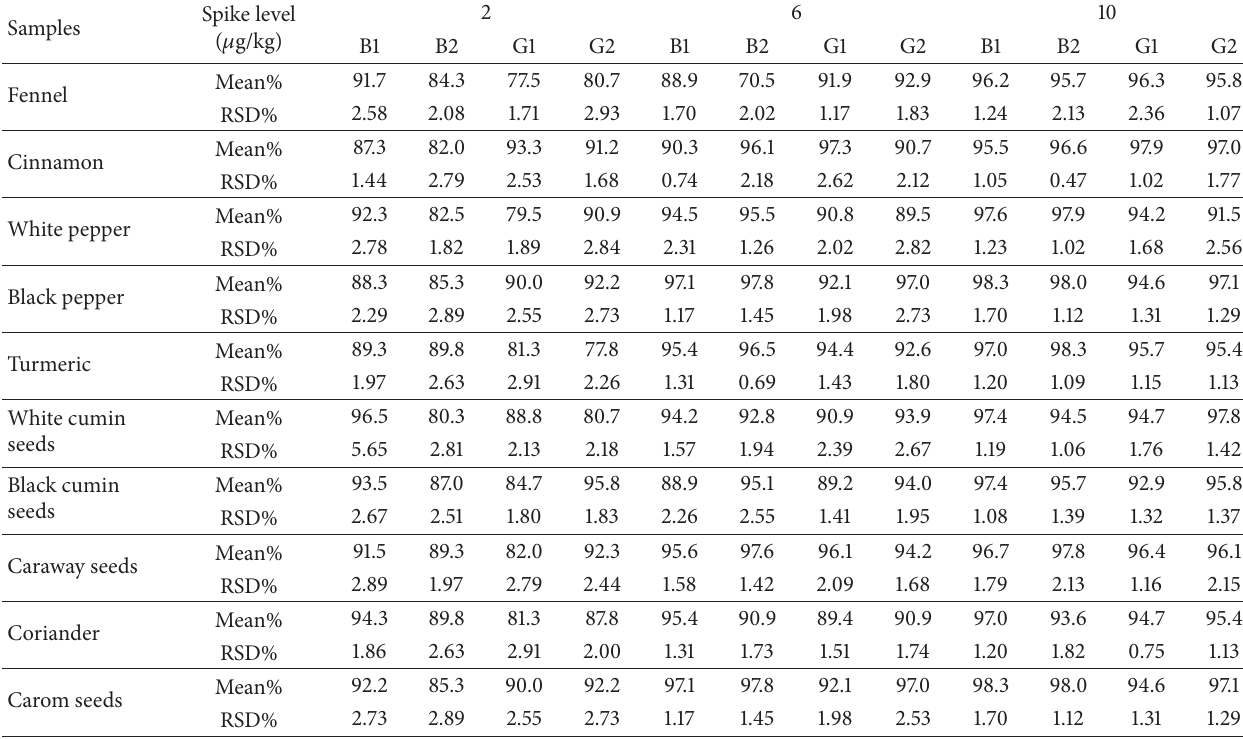
Table 1: Recoveries of aflatoxin from spiked spice